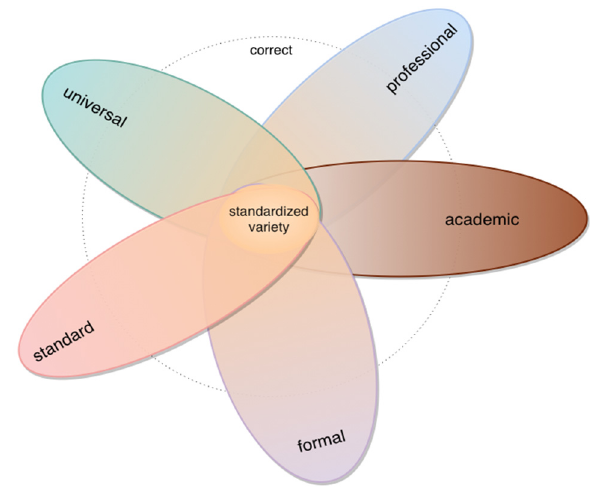
Figure 1. Overlapping terms that denote language standardization.